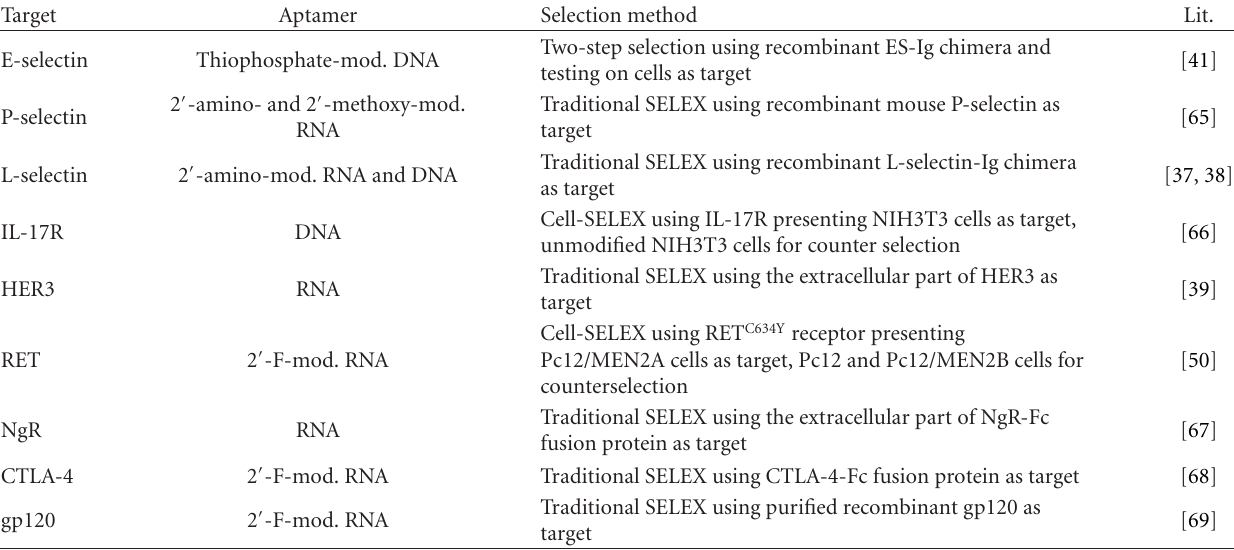
Table 2: Aptamers with inhibitory function on target molecules and corresponding selection strategies.